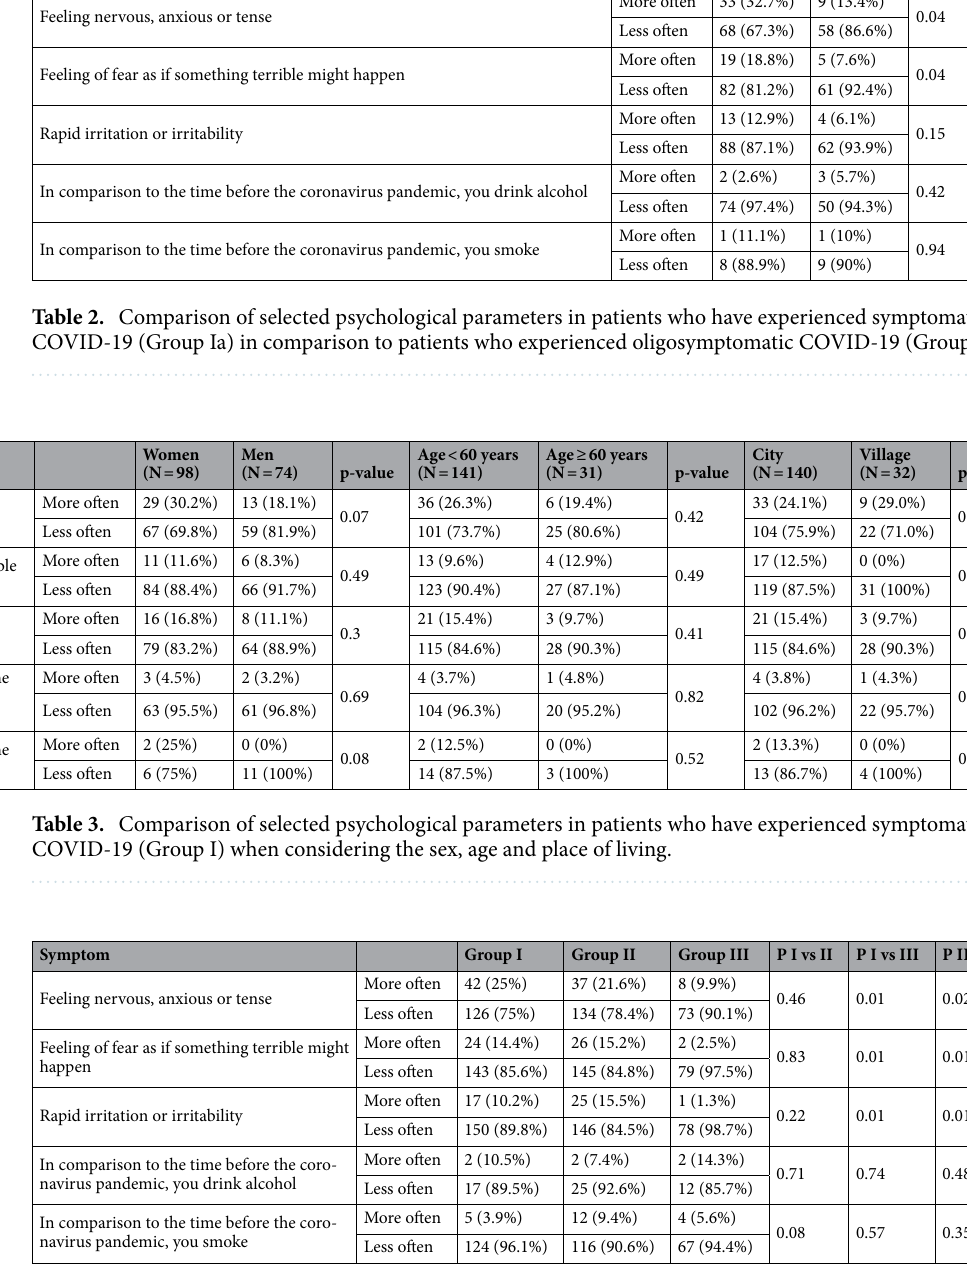
Table 4. Comparison of selected psychological parameters in patients who have experienced COVID-19 (Group I) in comparison to with coronary heart disease patients (Group II) and Bialystok Plus Group